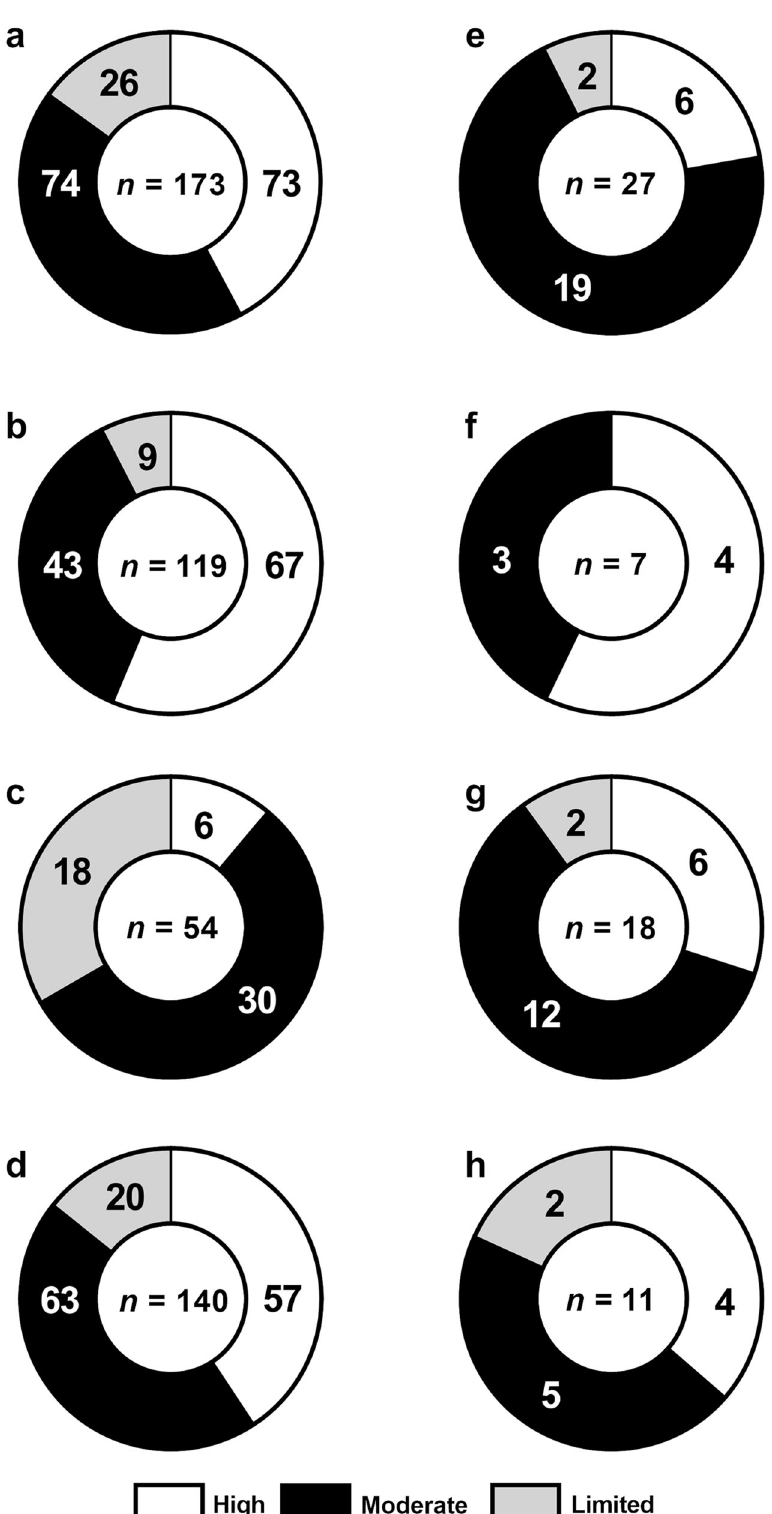
Fig. 1 Distribution of the quality of included studies investigating the role of iron and copper pathways in Parkinson ’ s disease etiology. Study quality for articles investigating the role of iron ( a – d ) and copper ( e – h ) pathways in the pathogenesis of Parkinson ’ s disease quanti fi ed using the revised Genoud Scale, and NIH Quality Assessment Tools. Distribution of quality of all eligible articles ( a , e ), clinical studies ( b , f ), post-mortem investigations ( c , g ), and studies investigating the role of iron and copper metal only ( d , h ). Studies considered limited quality were excluded from further